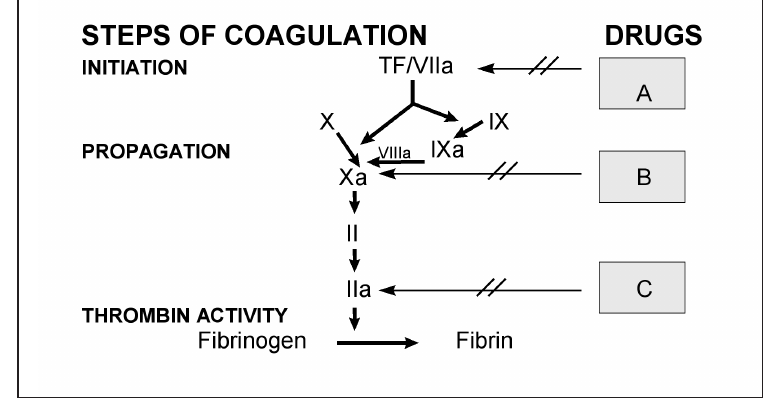
Targets of new anticoagulant drugs. A Inhibitors of the tissue factor/factor VIIa pathway B Specific inhibitors of factor Xa (example: fondaparinux [indirect], rivaroxaban [direct]) C Direct thrombin inhibitors (example: dabigatran etexilate)